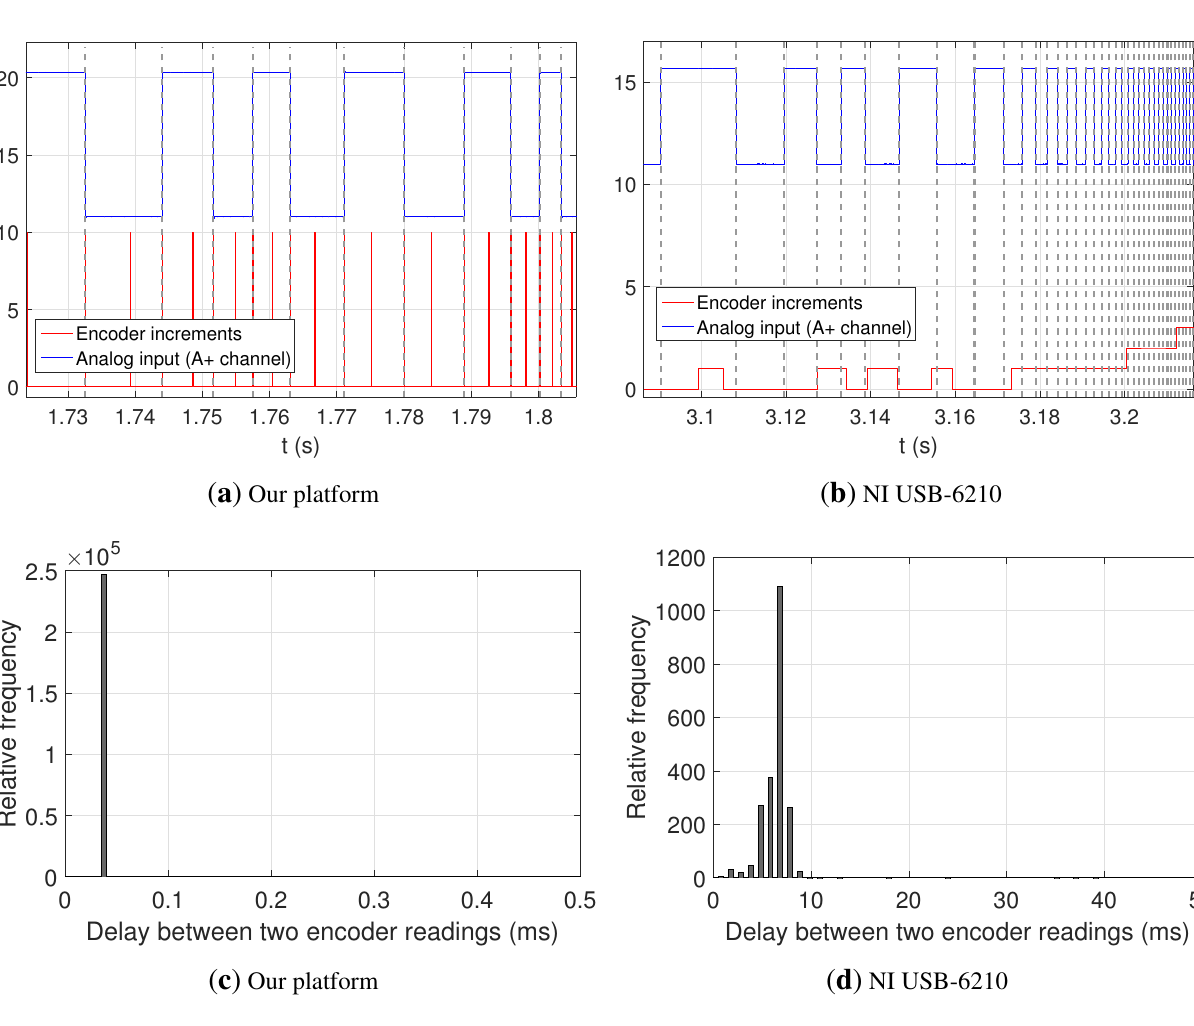
Figure 5. One channel ( A + ) from a quadrature encoder as an analog signal (blue) and increments in quadrature decoder counters (red) for both, our design ( a ) and a National Instrument USB-6210 board ( b ); For visual reference, we added vertical dashed lines marking the rising and falling edges of quadrature cycles. Vertical axes are not to scale; ( c , d ) Histograms of delays between the registration of counter values by each device. Refer to text for further